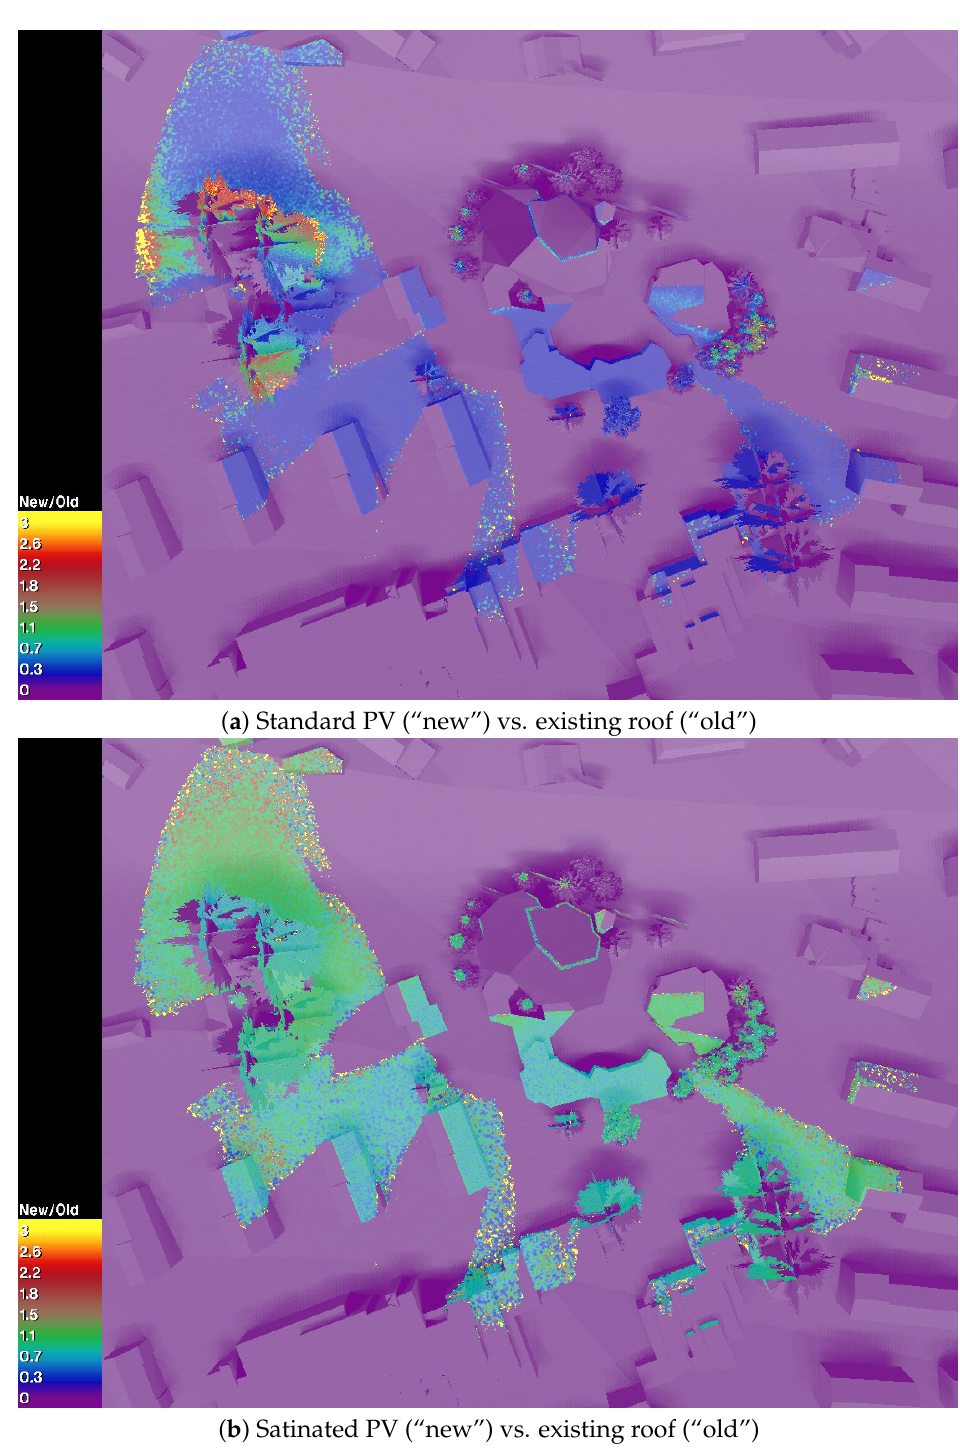
Figure 11. Plan views of reflection distribution from standard ( a ) and satinated ( b ) PV in relation to the existing roof tile, expressed as irradiance